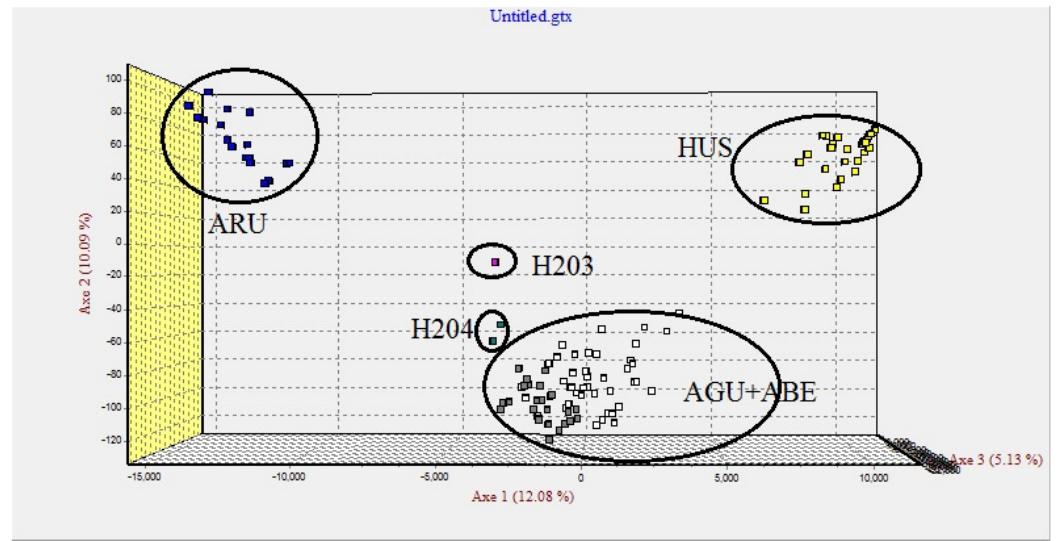
Figure 4. Factorial correspondence analysis (FCA) based on microsatellite data in four sturgeon species and two putative hybrids (H203 and H204). HUS— H. huso ; ARU— A. ruthenus ; AGU— A. gueldenstaedtii ; ABE— A. baerii .